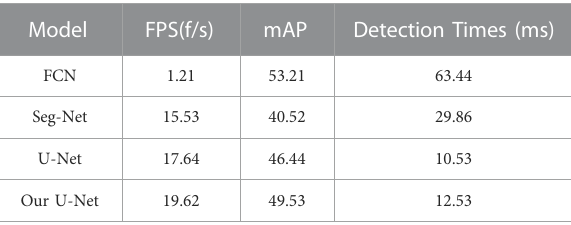
TABLE 1 The performance of different training